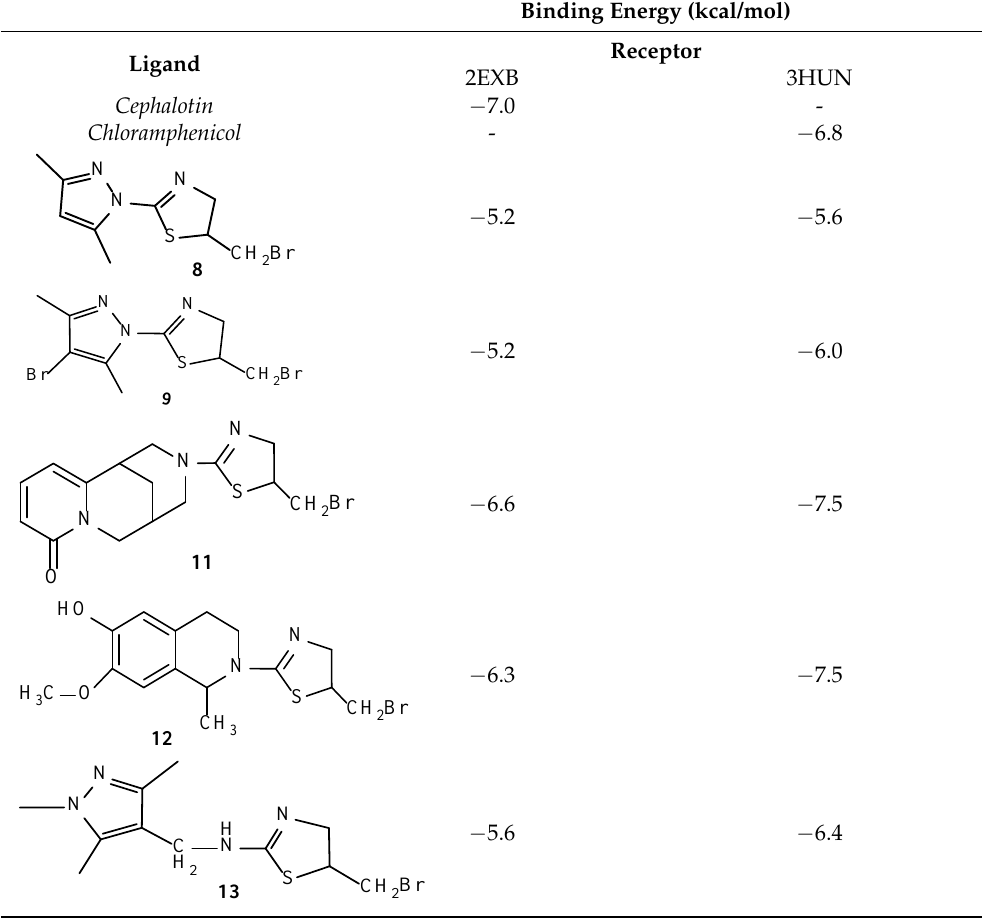
Table 1. Binding affinity (kcal/mol) of 1,3-thiazoline derivatives with active sites of penicillin bind-